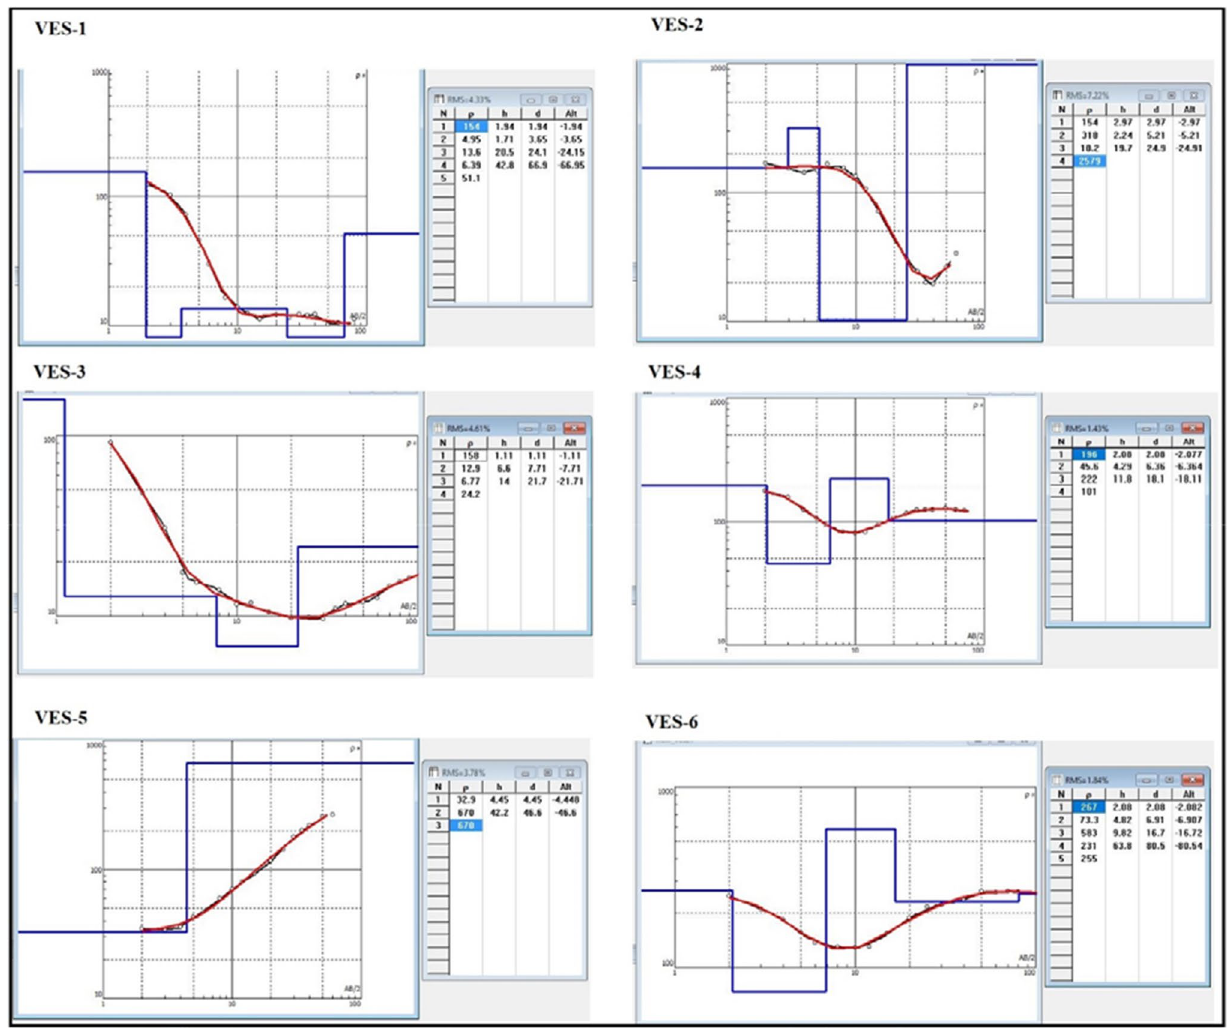
Fig. 15 The Schlumberger responses of interpreted VES curve Table 6 Subsurface layer parameters of vertical electrical sounding